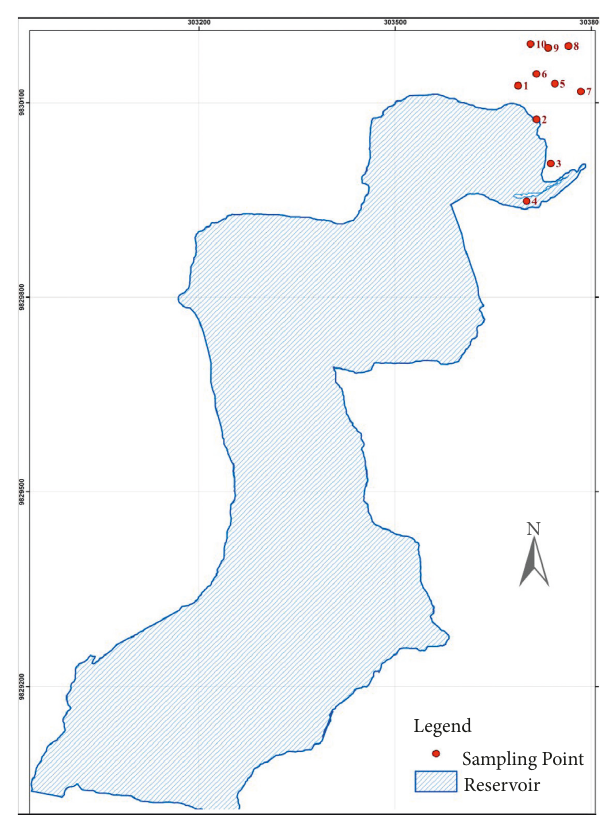
Figure 2: Sampling points at the reservoir